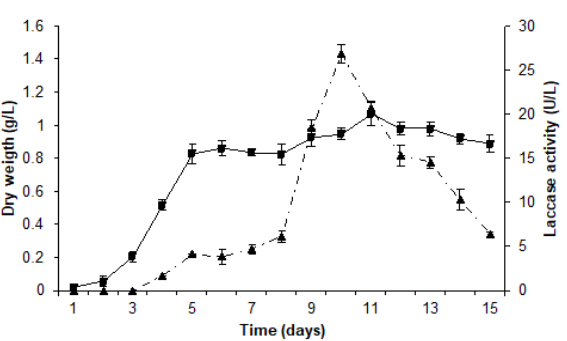
Figure 1. Growth and laccase production kinetics of T. terrestris Co3Bag1. Growth ( (cid:4) ) and laccase activity ( (cid:78) , dotted line) kinetics of T. terrestris Co3Bag1 in medium Zouari Mechichi et al. [21]. Dry cell weight monitored growth, and laccase activity was assayed using ABTS as